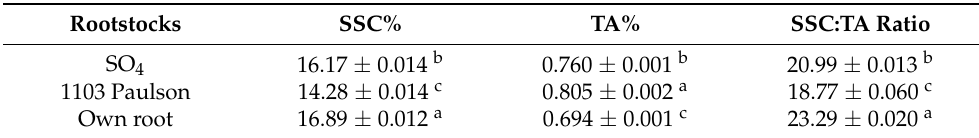
Table 7. The different rootstocks of “superior seedless” vine on growth and properties of selected bunches at harvest